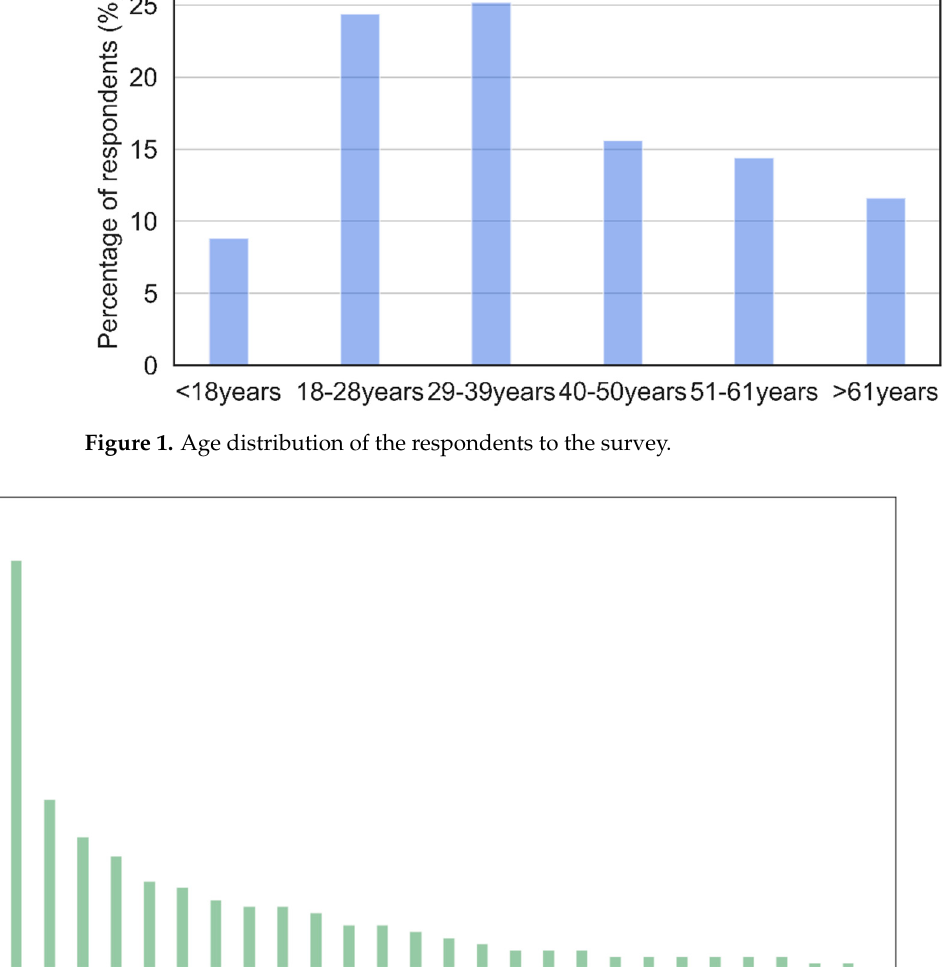
Figure 1. Age distribution of the respondents to the survey.